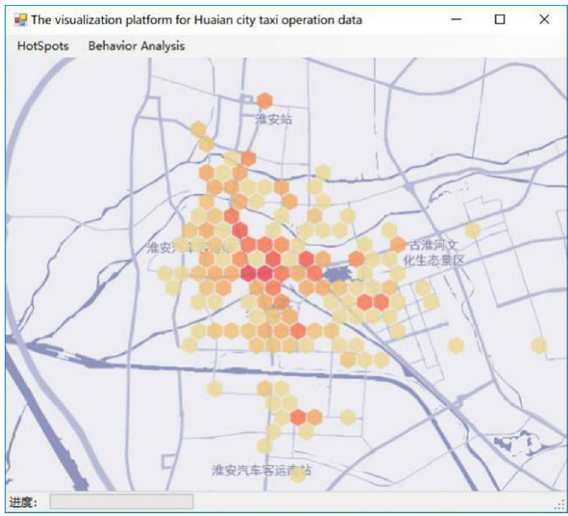
Figure 10. The diagram of Honeycomb heat diagram visualized effect 28 .